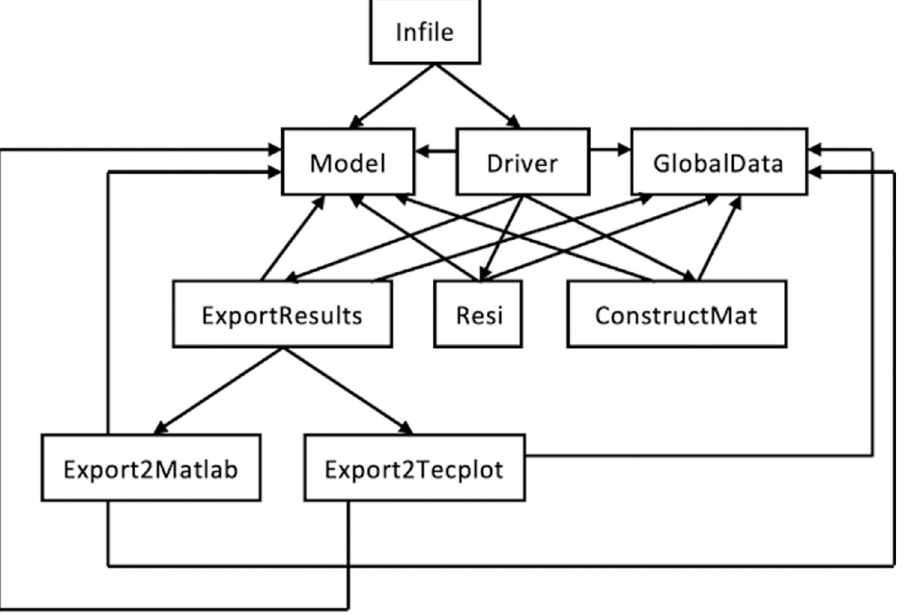
Fig 9. The nine modules in the code of the decoupled scheme of matrix acidization. The arrow represents the calling relationship between two modules, i.e., the module at the tail of the arrow will call the module at the head of the